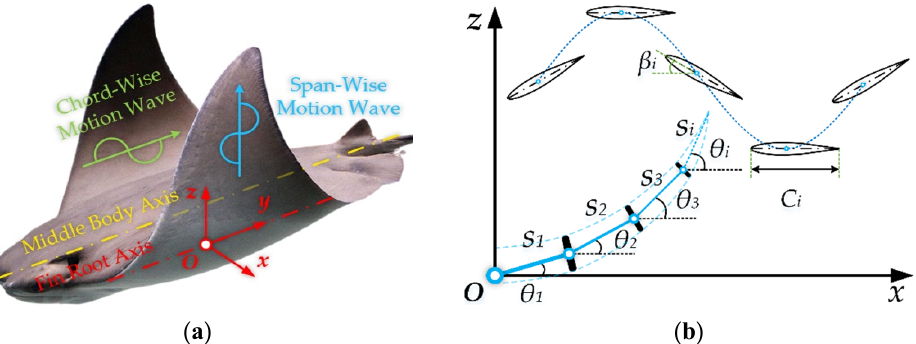
Figure 1. Kinematic model. ( a ) Definition of the pectoral fin coordinate system; ( b ) Discretization and motion decoupling of the pectoral fin.